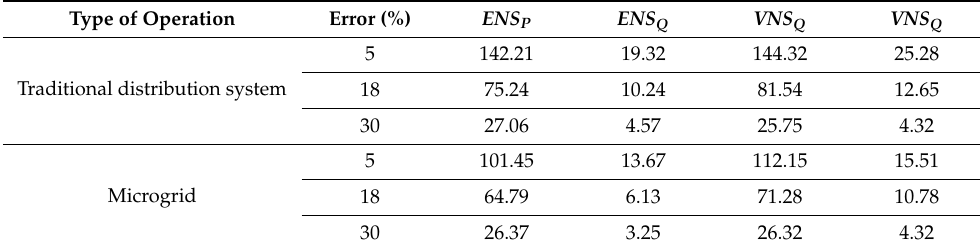
Table 10. Error analysis in the designed